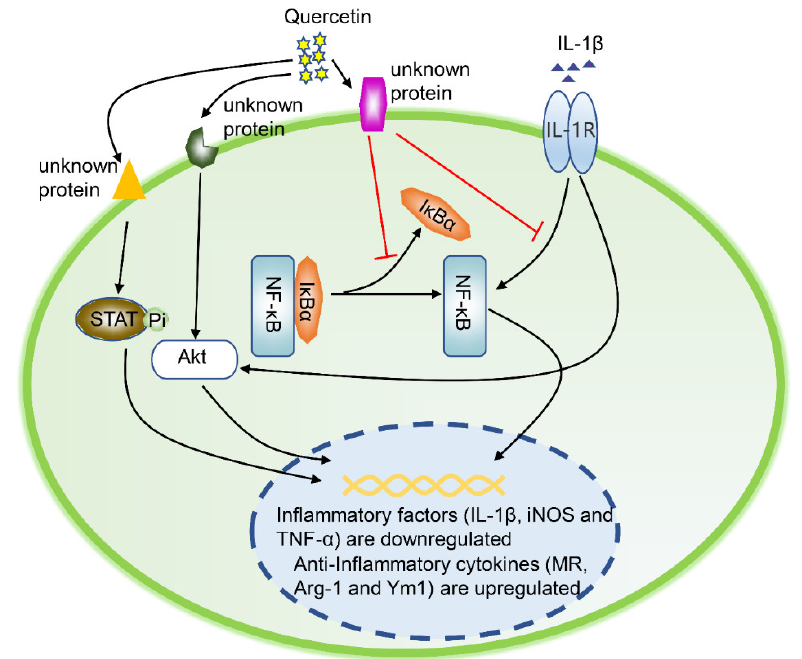
Figure 3. Quercetin regulates the polarization of macrophages. In the inflammatory state caused by IL-1 β , a series of signaling pathways in macrophages are activated, including AKT phosphorylation, I κ B α degradation, and p65 phosphorylation. In response to quercetin stimuli, STAT6 and Akt are phosphorylated, promoting STAT6’s entry to the nucleus. Subsequently, the expression of M2 macrophage-related genes (MR, Arg-1, and Ym1) is up-regulated. Eventually, the macrophages are polarized into M2. IL-1 β , interleukin-1 β ; AKT, protein kinase B; I κ B α , inhibitor of NF- κ B; STAT6, signal transducer and activator of transcription 6; MR, mannose receptor; Ym1, chitinase 3-like protein 3; Arg-1, arginase-1.